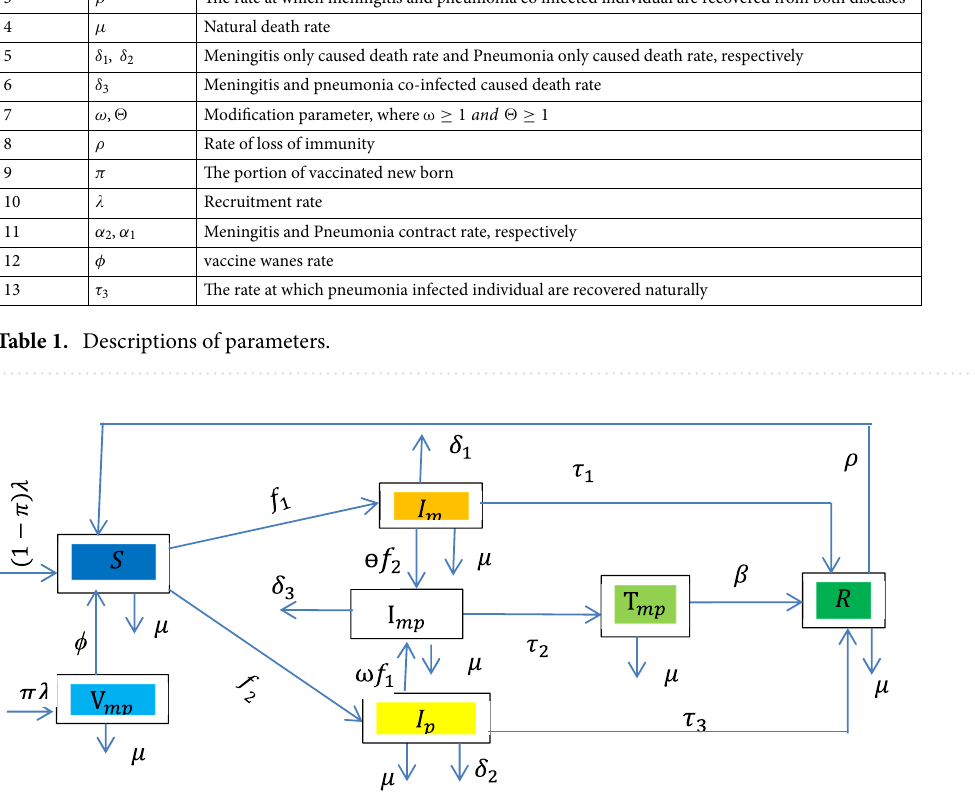
Figure 1. Flow chart of meningitis and pneumonia